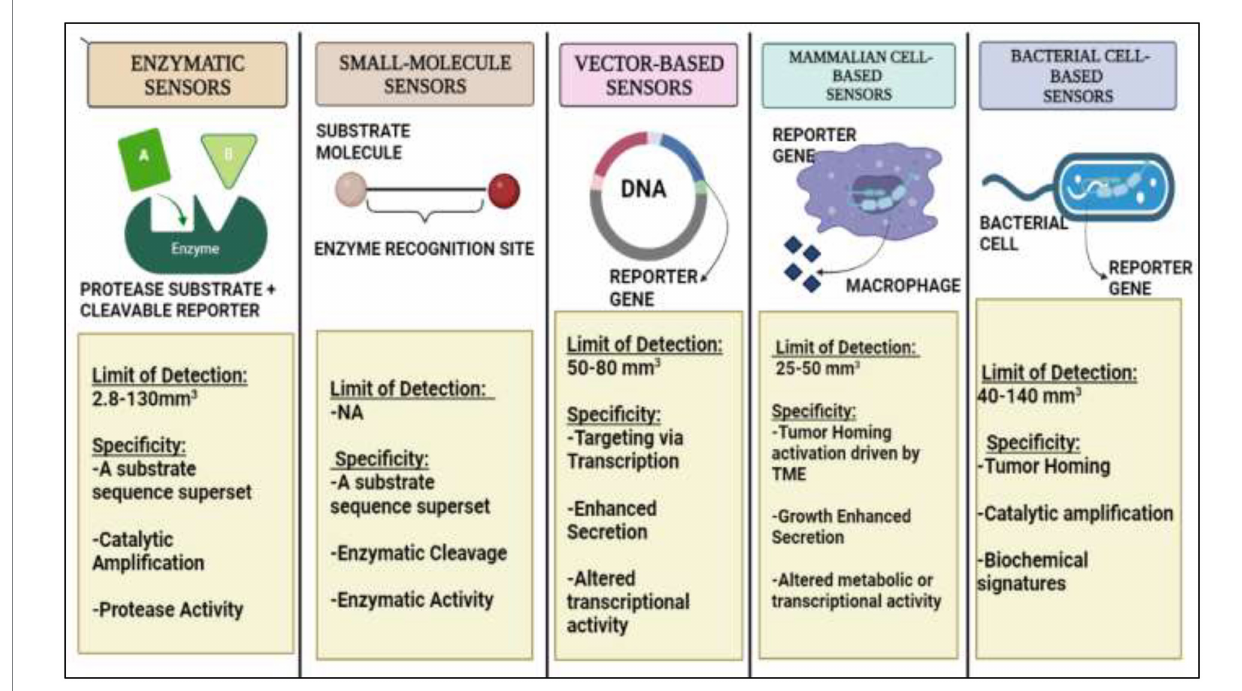
FIGURE 1 A detailed diagrammatic overview of Synthetic Biomarkers on the basis of their activity and various methodologies for endogenous